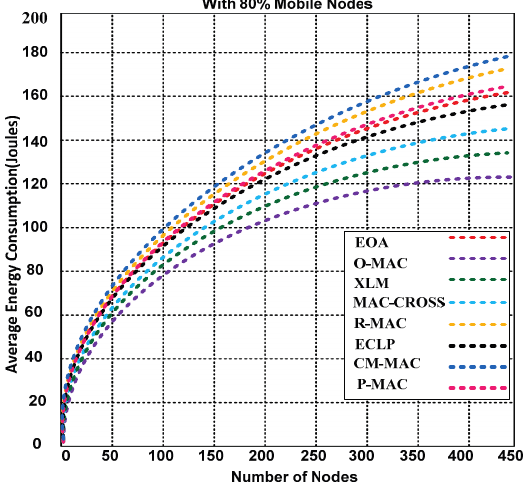
Figure 11. Energy consumption of O-MAC and other competing hybrid MAC protocols with 80% mobile